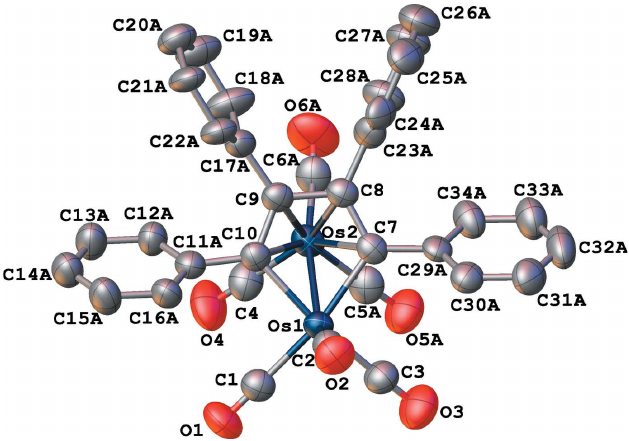
Figure 1 The molecular structure of the title compound, showing the positions of the major phenyl-ring and carbonyl-ligand components, as well as the atom-labelling scheme. Displacement ellipsoids are shown at the 50% probability level and H atoms have been omitted for clarity.